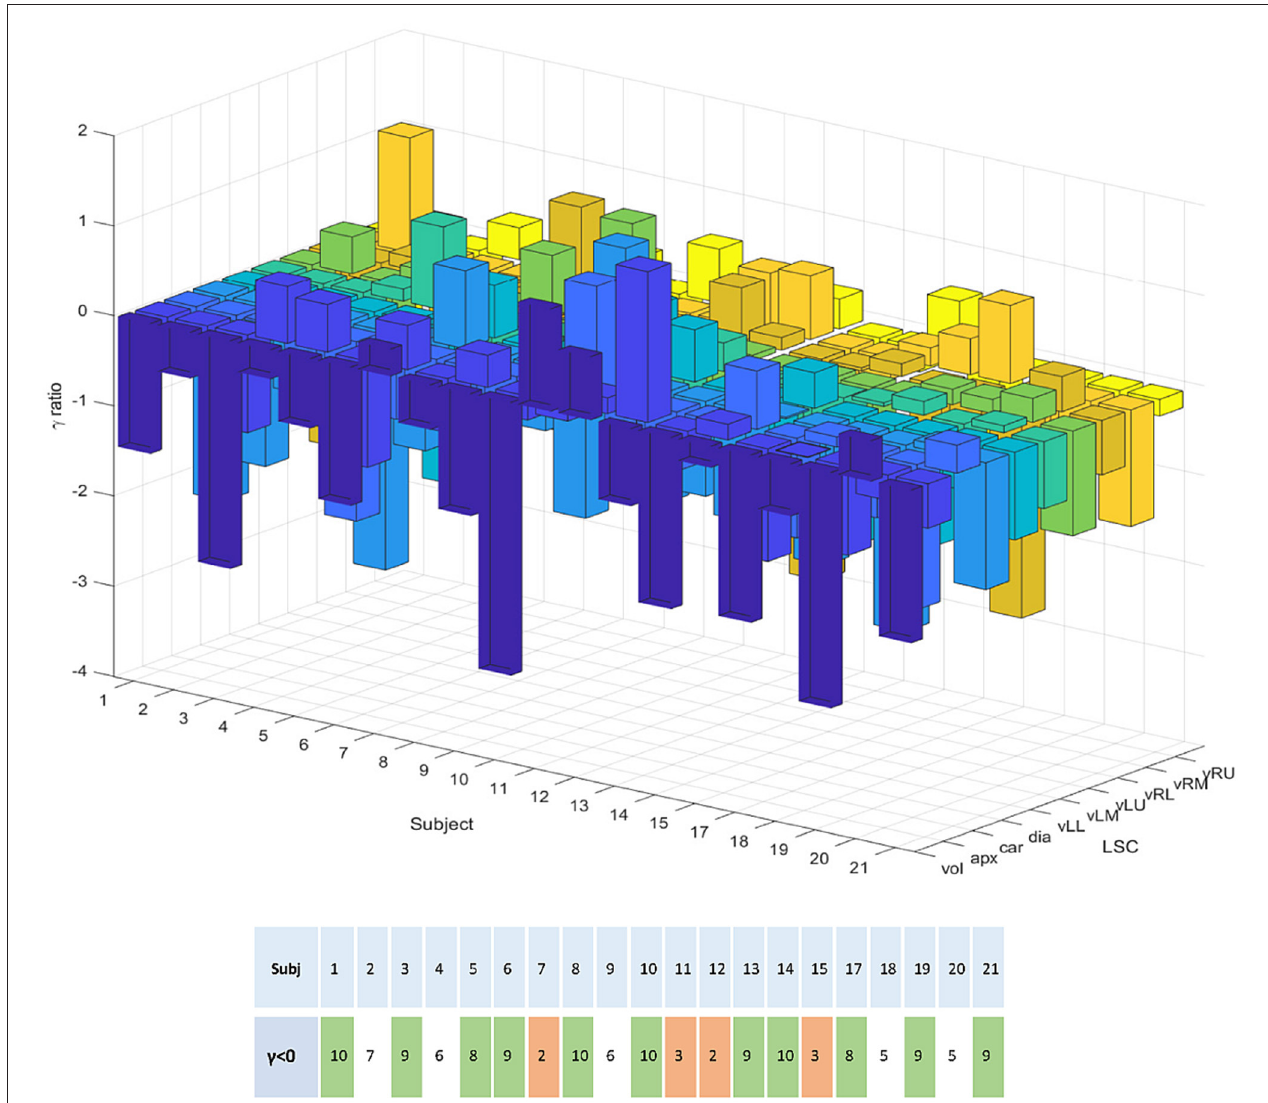
FIGURE 8 | The 3D bar plot displays the logarithm of the ratio, denoted γ , of relative errors in lung structure radial distances and volumes between the motion mitigation methods, eDIBH and HFPV, for each subject, and lung structure or volume. The lower table assigns to each subject the number of values for which the γ ratio is negative, indicating less variability with eDIBH. Green indicates numbers > 7, orange those < 4. White indicates intermediate